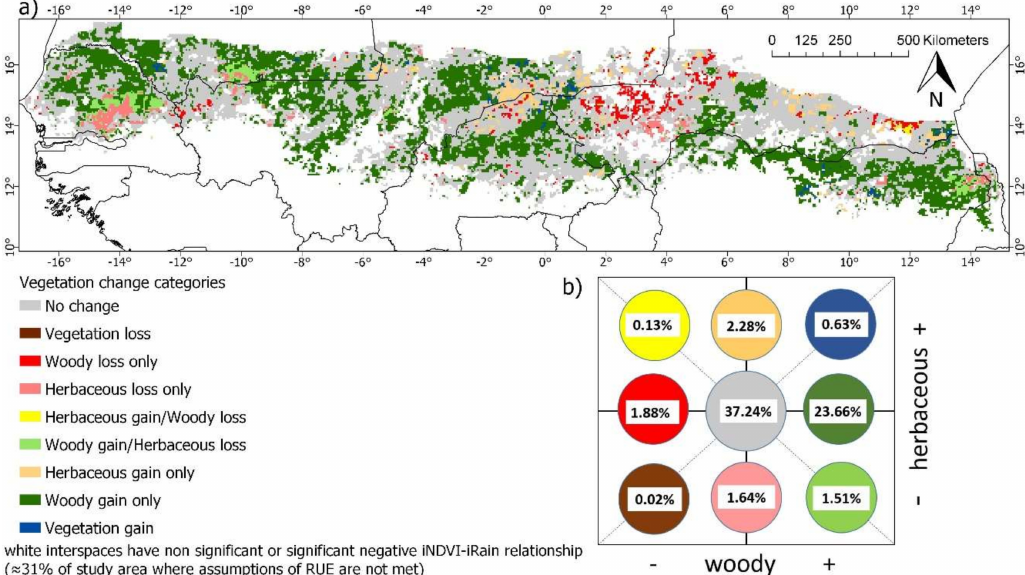
Figure 9. Concurrent woody and herbaceous vegetation changes between the 1982–1991 and 2004–2013 decades in the WASS region based on δ S L and δ S S values derived assuming the best (AIC-selected) productivity-rainfall relationship at each location. ( a ) Map of vegetation change categories, ( b ) Chart showing conceptual position and the relative abundance of each category in a 2-D space. Both figures share the same color